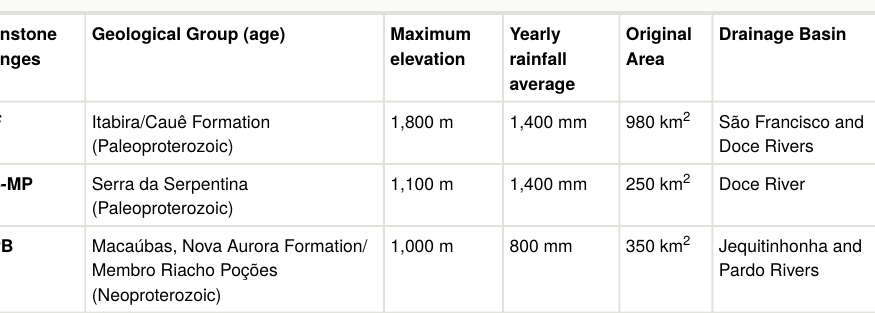
Physical and geographical variables of ironstone ranges in south-eastern Brazil. QF: Quadrilátero Ferrífero; SS-MP: Serra da Serpentina-Morro do Pilar; VPB: Vale do Rio Peixe